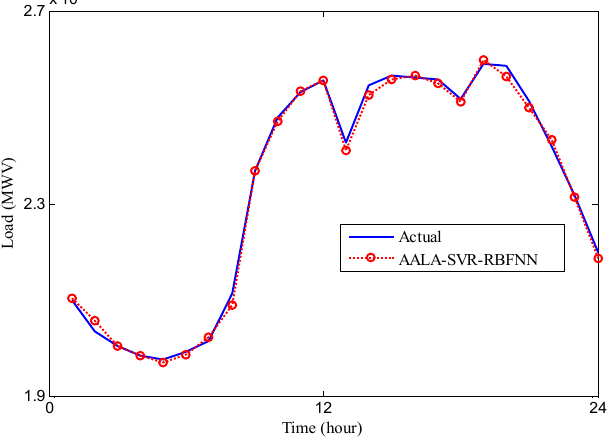
Figure 4. The forecasting results of the proposed AALA-SVR-RBFNN in Case 1. Table 3. MAPE (%) and SDAPE (%) results for prediction methods in Case 1.